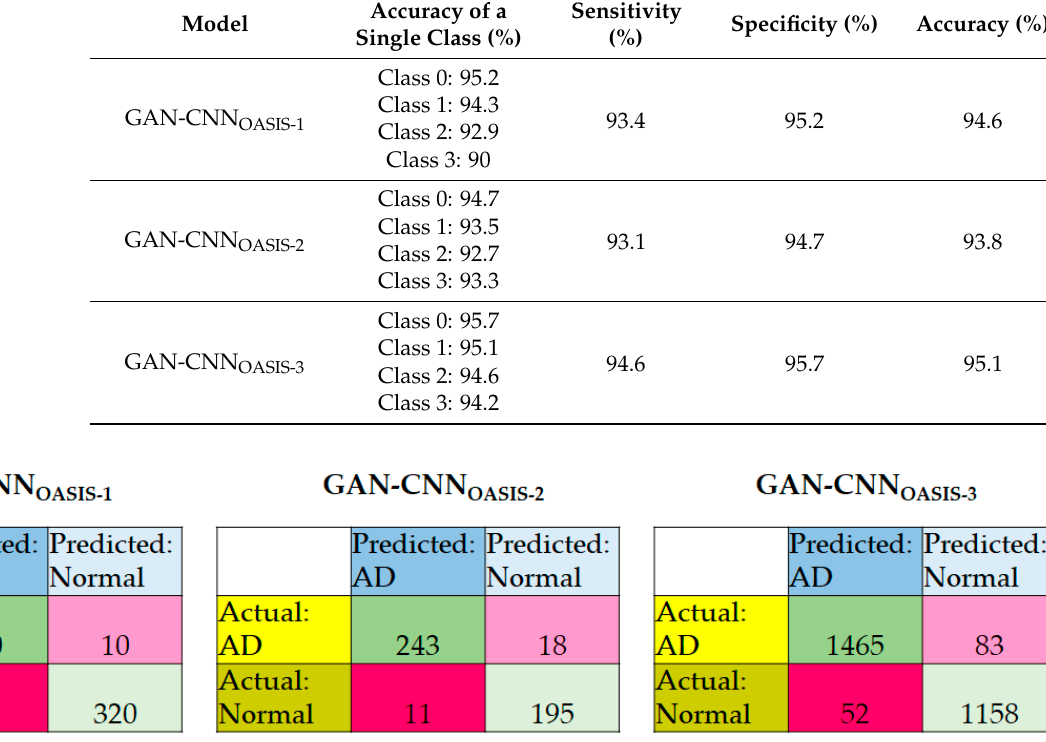
Figure 6. Confusion matrices of the GAN-CNN OASIS-1 , GAN-CNN OASIS-2 , and GAN-CNN OASIS-3 .